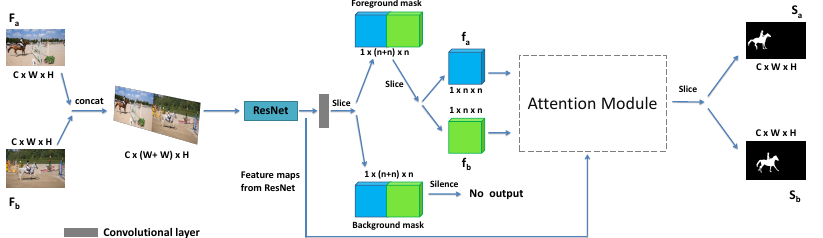
Figure 1. The pipeline of our framework with a new attention module for video co-segmentation. Two video frames { F a , F b } are concatenated together in a concat layer before processing by the convolutional neural network; the concatenated data are then fed into the ResNet as the baseline for feature extraction. Then, two one-channel feature maps { f a , f b } from the baseline are fed into our attention module for common information extraction. Finally, two segmentation results { S a , S b } belonging to the two input frames { F a , F b }, respectively, are